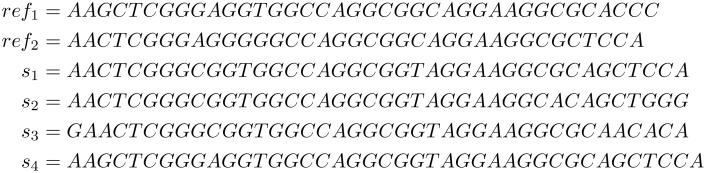
Sequences for Example 1.